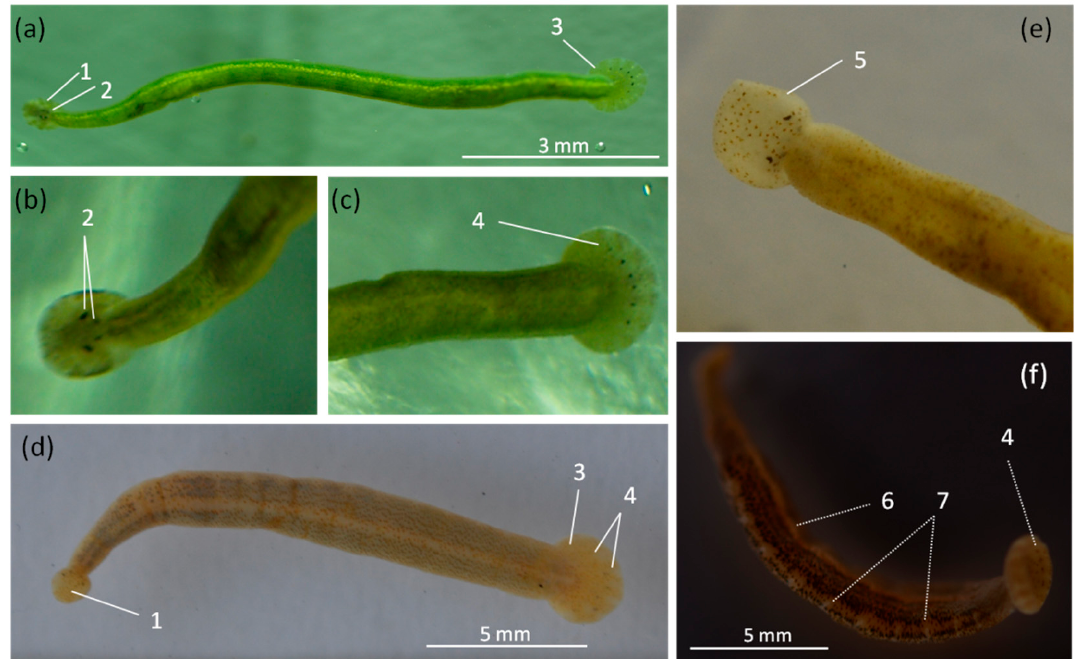
Figure 5. Morphology of Piscicola sibirica sp. nov.: ( a ) exterior of living junior leech from Lake Baikal (voucher K79), ( b ) region of cephalic end with trachelosome and sucker, ( c ) fragment of urosome with caudal sucker, ( d ) exterior of fixed adult leech from Angara River (voucher KM15), ( e ) anterior end of fixed specimen from the Irkutsk reservoir (M51) and ( f ) external morphology of fixed specimen (M51). Numerical designations: 1—cephalic end, 2—eyes, 3—caudal sucker, 4—eye-like spots, 5—depigmented area, 6—median band and 7—pulsatory vesicles.